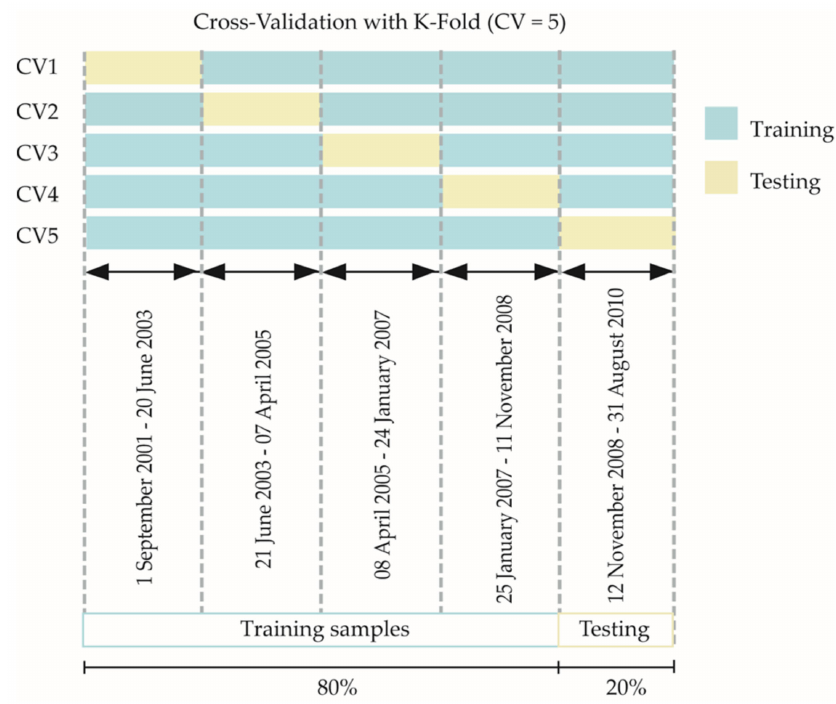
Figure 5. Schematic illustration of cross-validation splitting